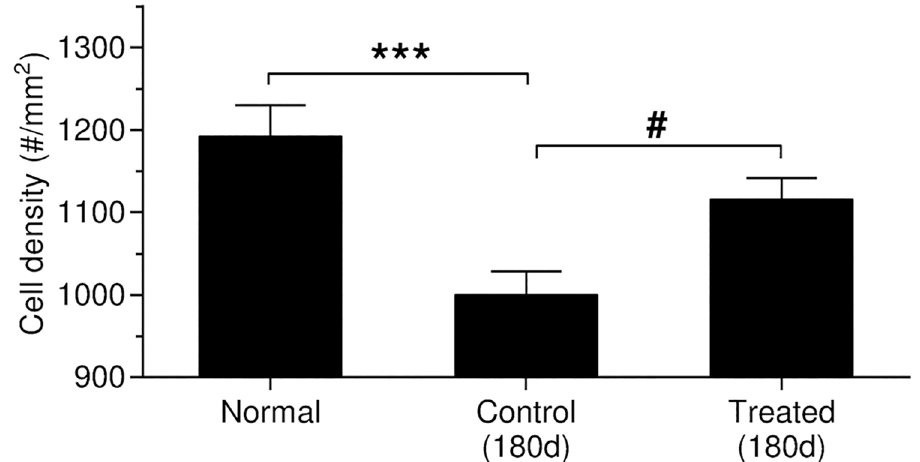
Fig 16. Fibrocyte density is calculated and statistically analyzed in the spiral ligament in the middle and basal turns. Significant lower cell density in the spiralligament is only observedin the control (noise exposure, untreatedgroup) 6 months after noise exposure( *** , p < 0.001), and significantrecovery is observedin the treated groups6 months after noise exposure(#) comparedto the control group ( p <